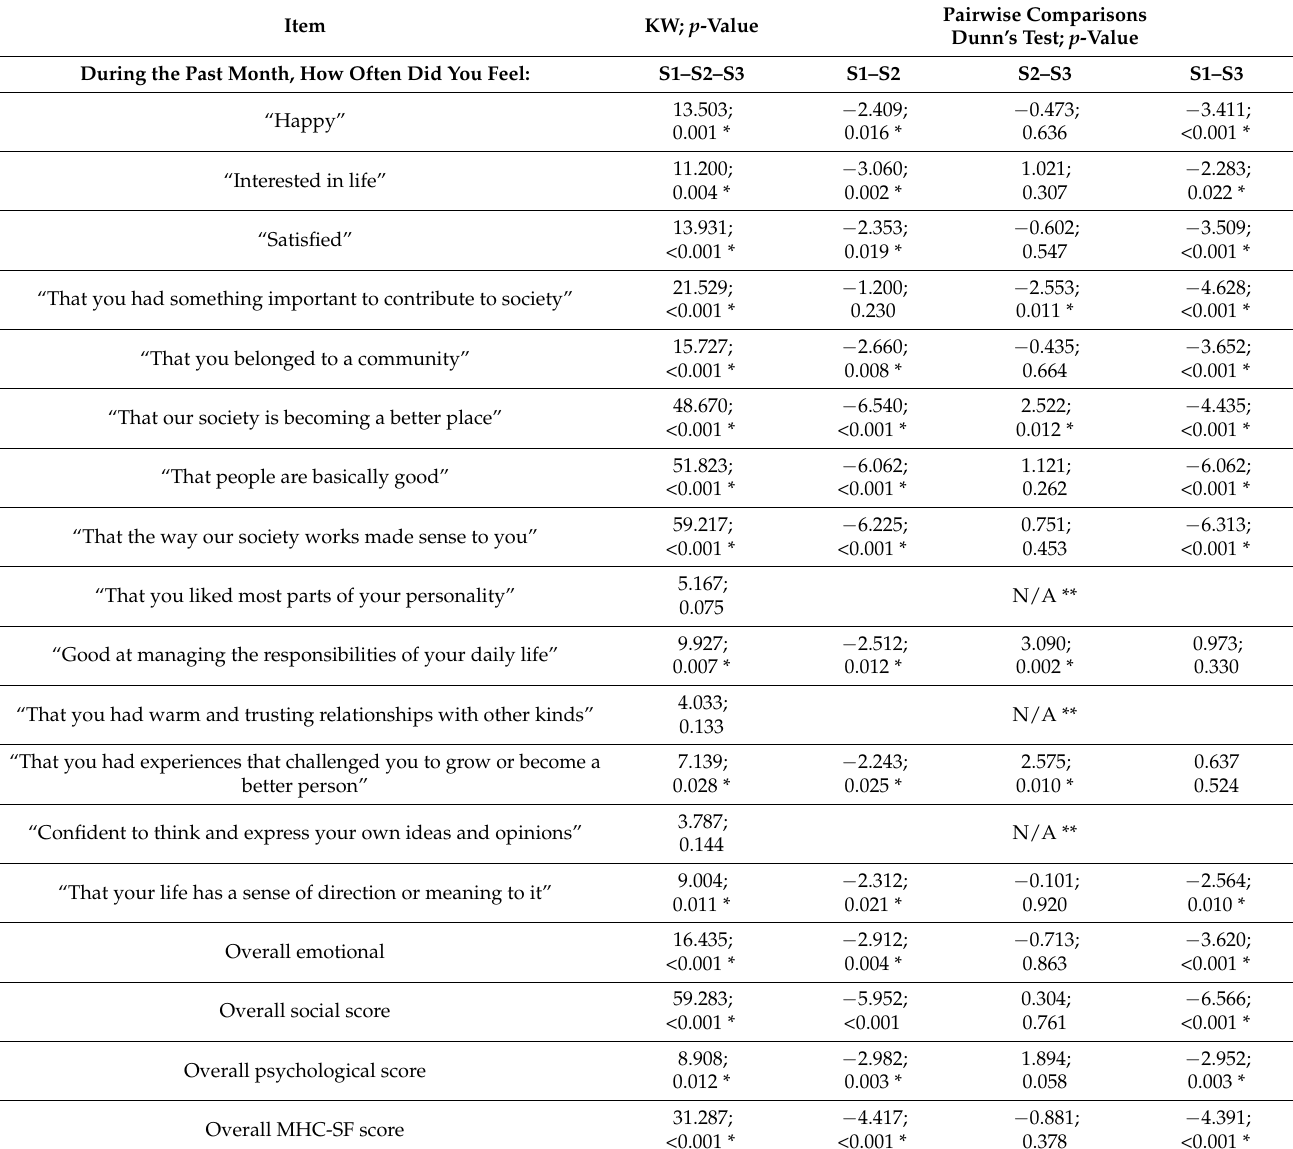
Table 4. Results of the